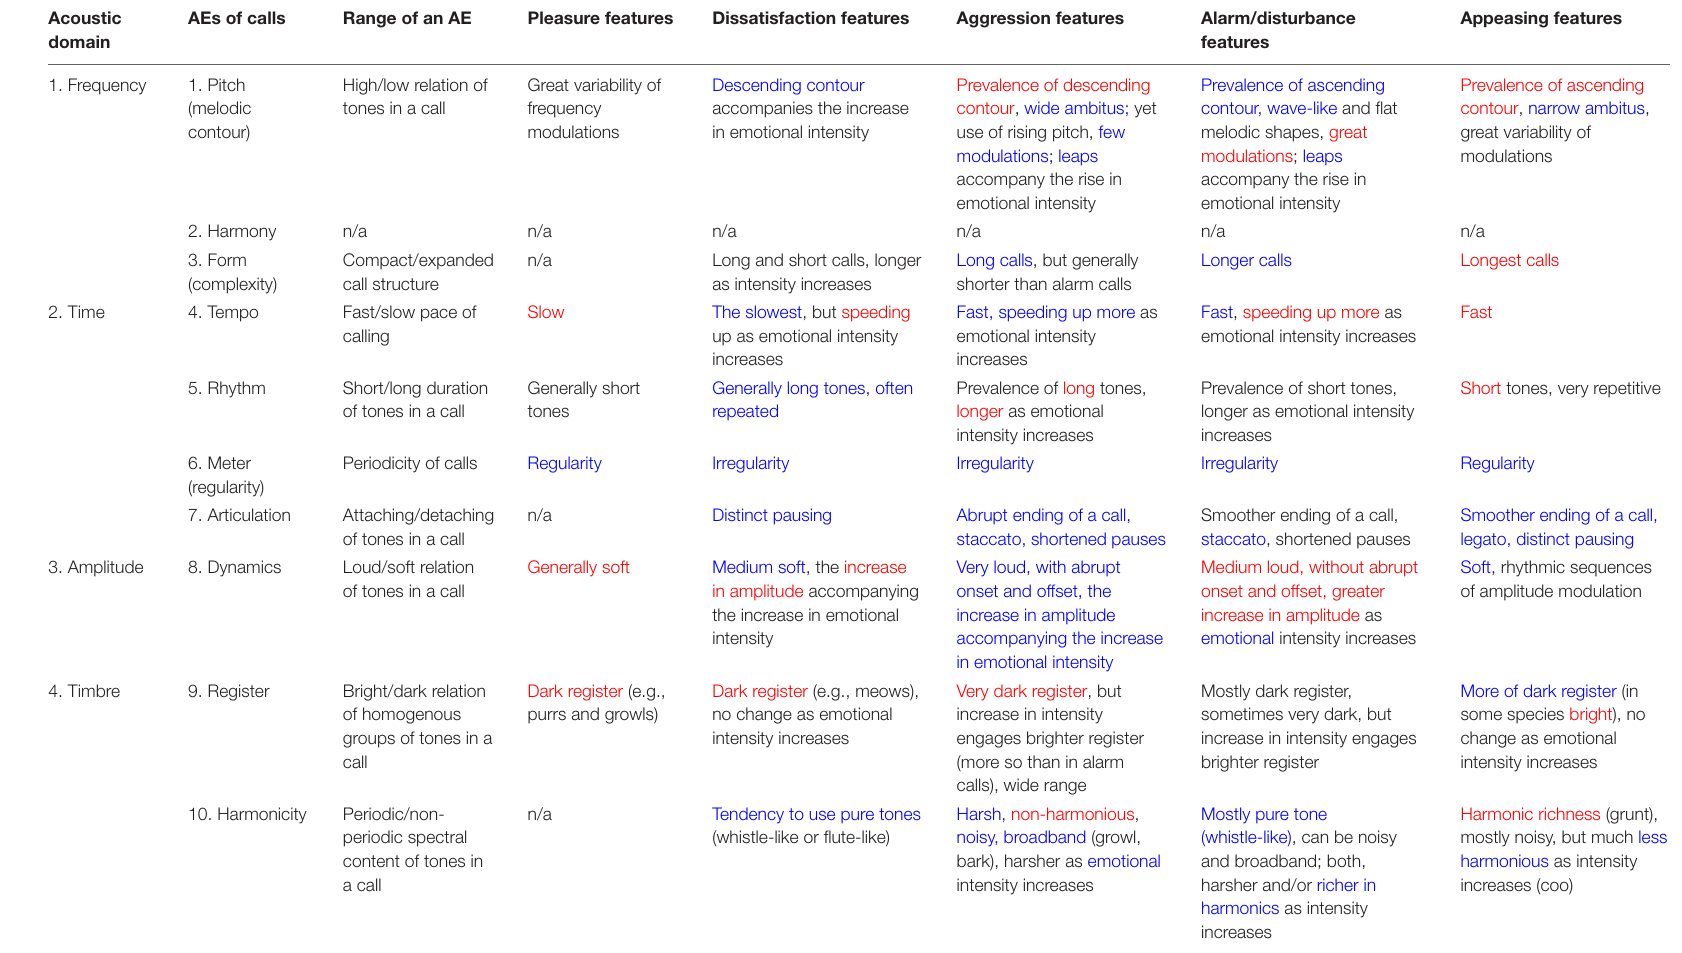
TABLE 4 | Acoustic attributes of typical animal vocalizations used by different species to display their affective state, grouped according to AEs of human music. Acoustic